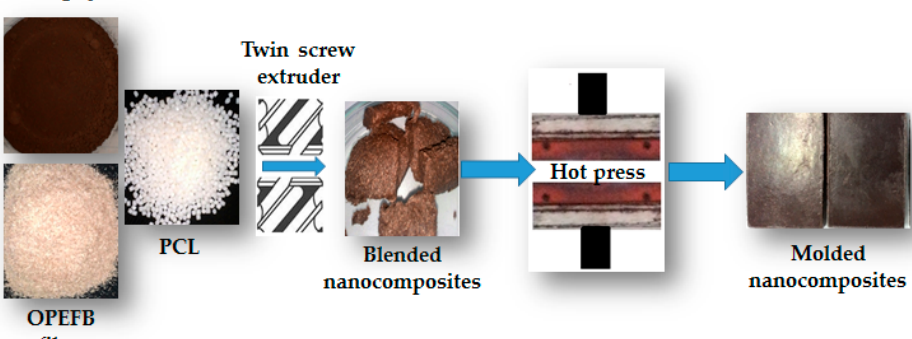
Figure 1. Nanocomposite fabrication. PCL, polycaprolactone.